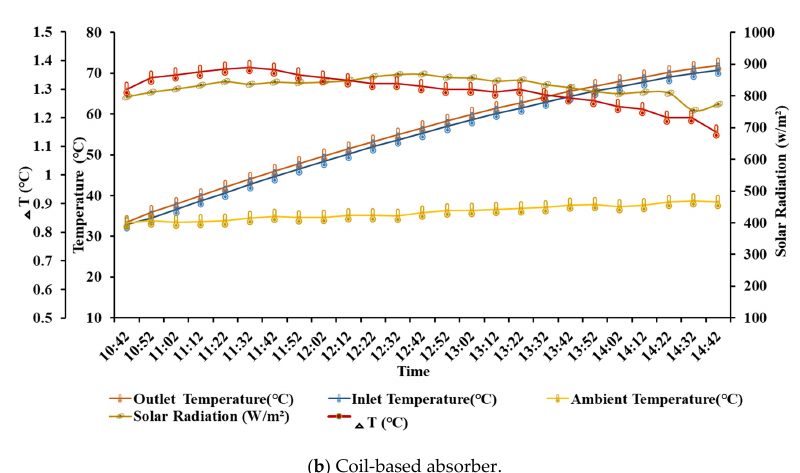
Figure 4. Measured temperature variations and solar radiation in existing absorber tube ( a ) and coil-based absorber ( b ) using CuO-nanofluid as heating medium (22 June 2020).